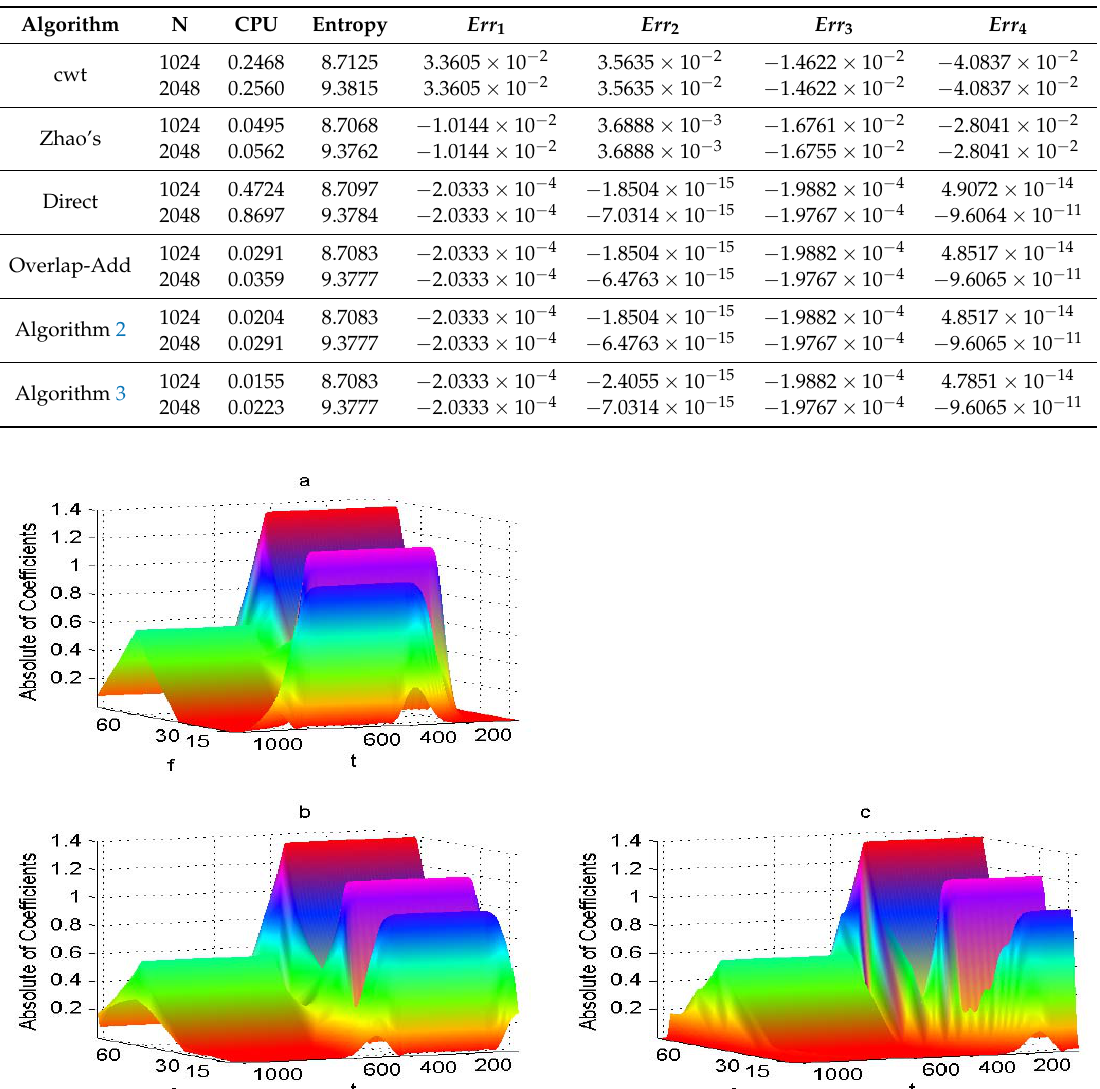
Table 1. Comparisons between the different CWT methods for Data 1.